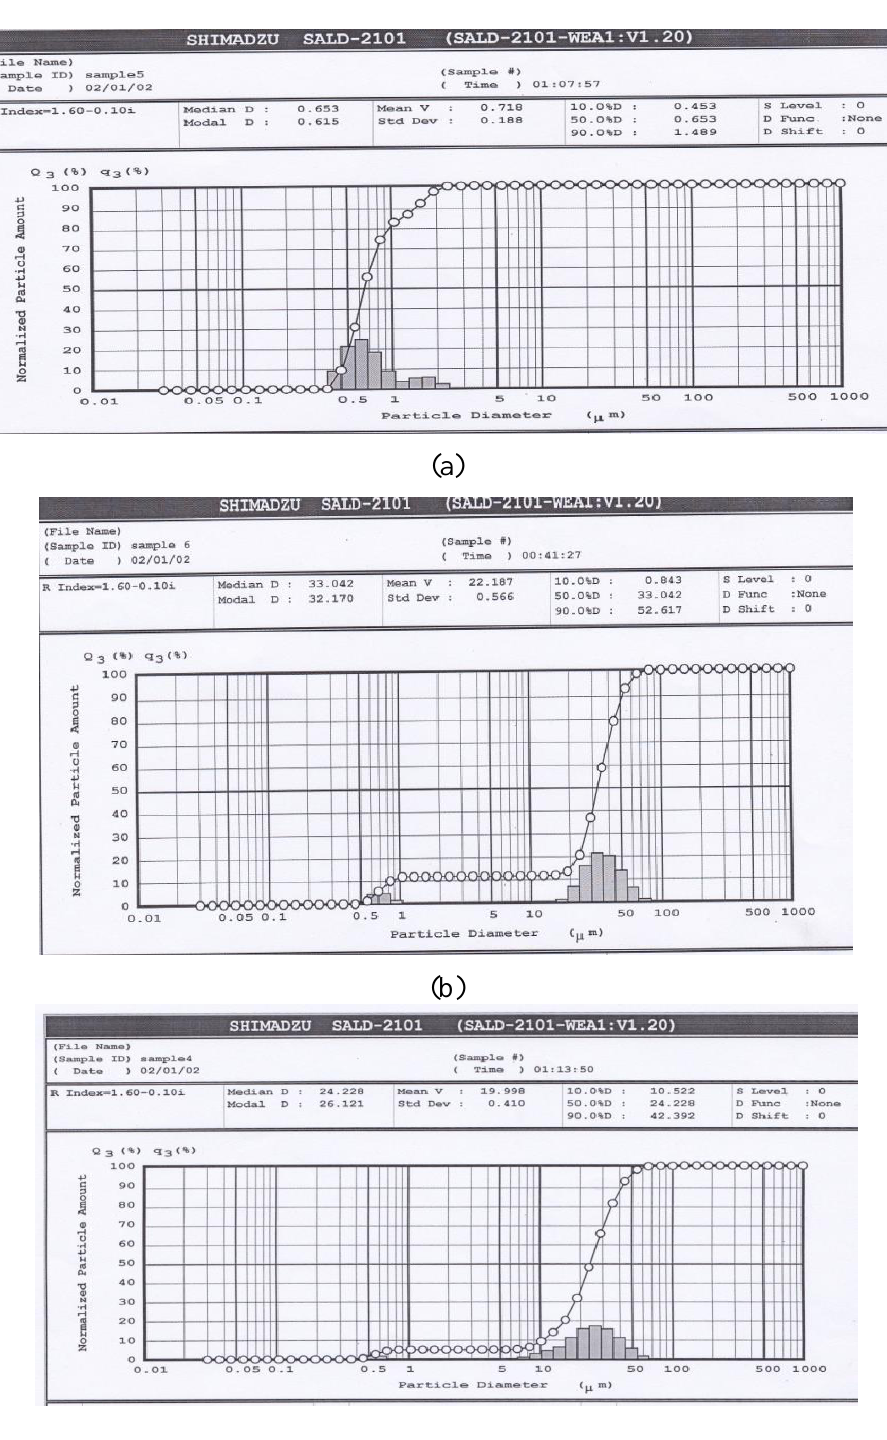
Fig.2: (a) Particle size of CaCO